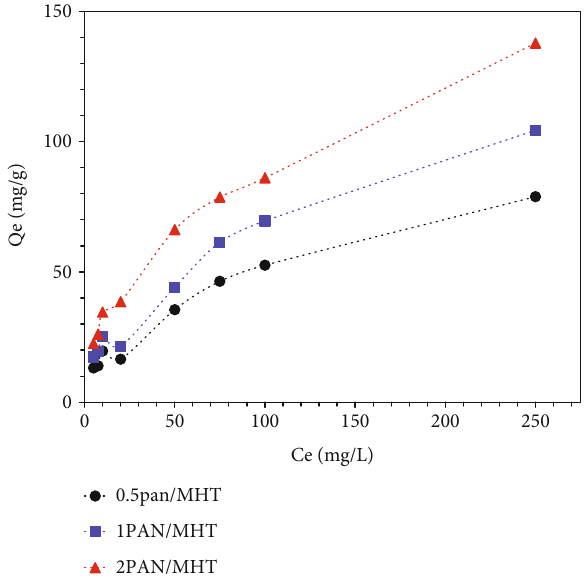
Figure 12: E ff ect of initial MO concentration on MO adsorption onto 0.5 Pan/MHT, 1 Pan/MHT, and 2